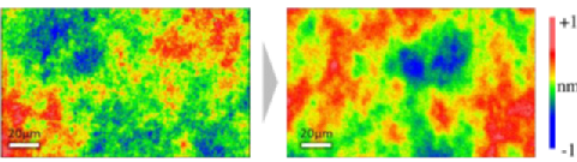
Fig. 2. Phase shift interference microscopy images of the as- received (left, 0.15 nm RMS) and CARE-processed (right, 0.1 nm RMS) LN surface.